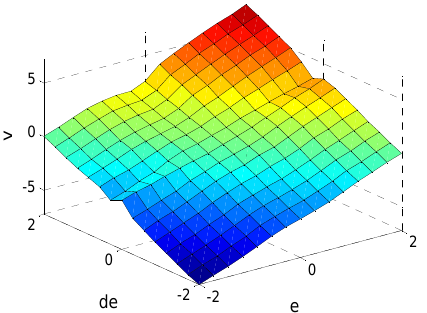
Fig. 9. Control surface of the PDFLC in Example 1.